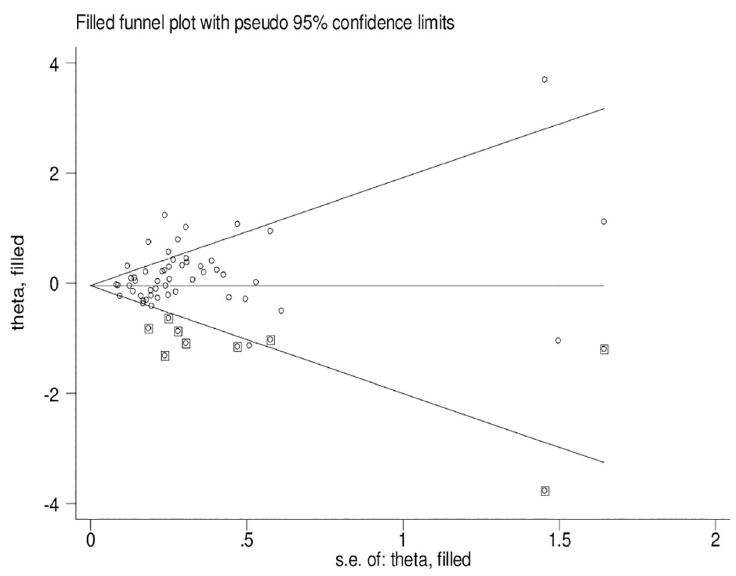
Fig 4. The duval and tweedie nonparametric “trim and fill” method’s funnel plot of the CYP1A1 A3801G polymorphism (AG+GG vs. AA).